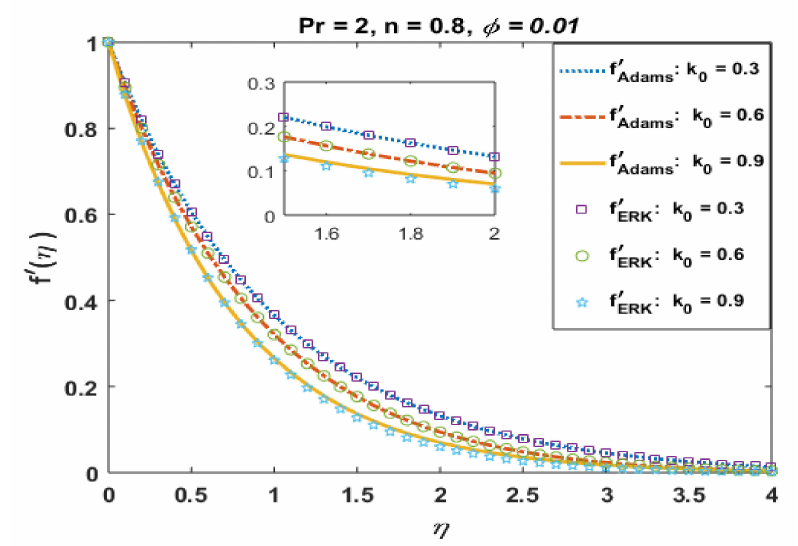
Figure 1. Effects of k 0 on f (cid:48) ( η ) .